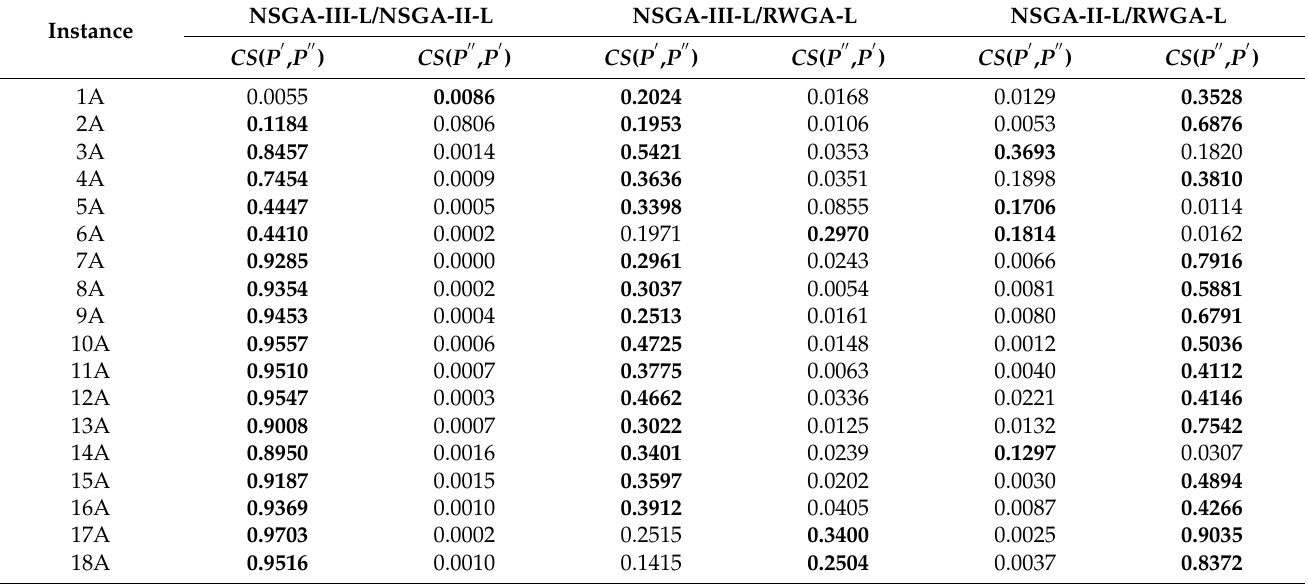
Table 10. Experimental results of CS